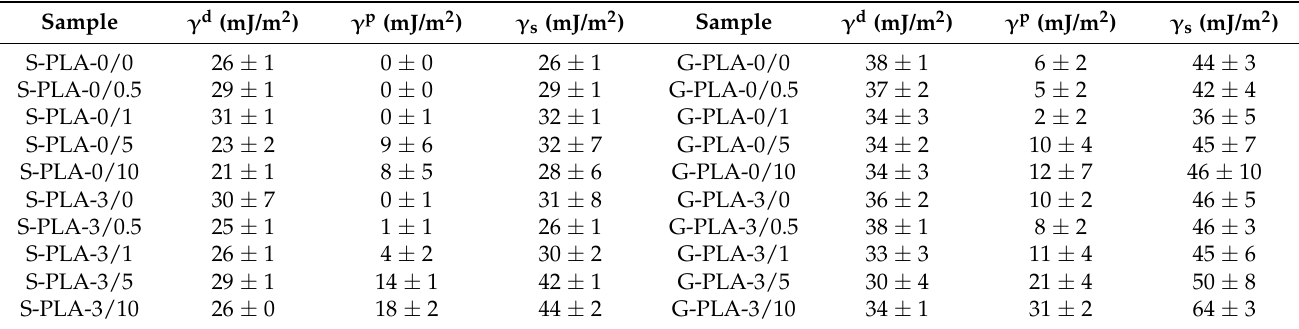
Table 2. The dispersive ( γ d) and polar ( γ p) components and the surface tension of the solid ( γ S), calculated using the Fowkes